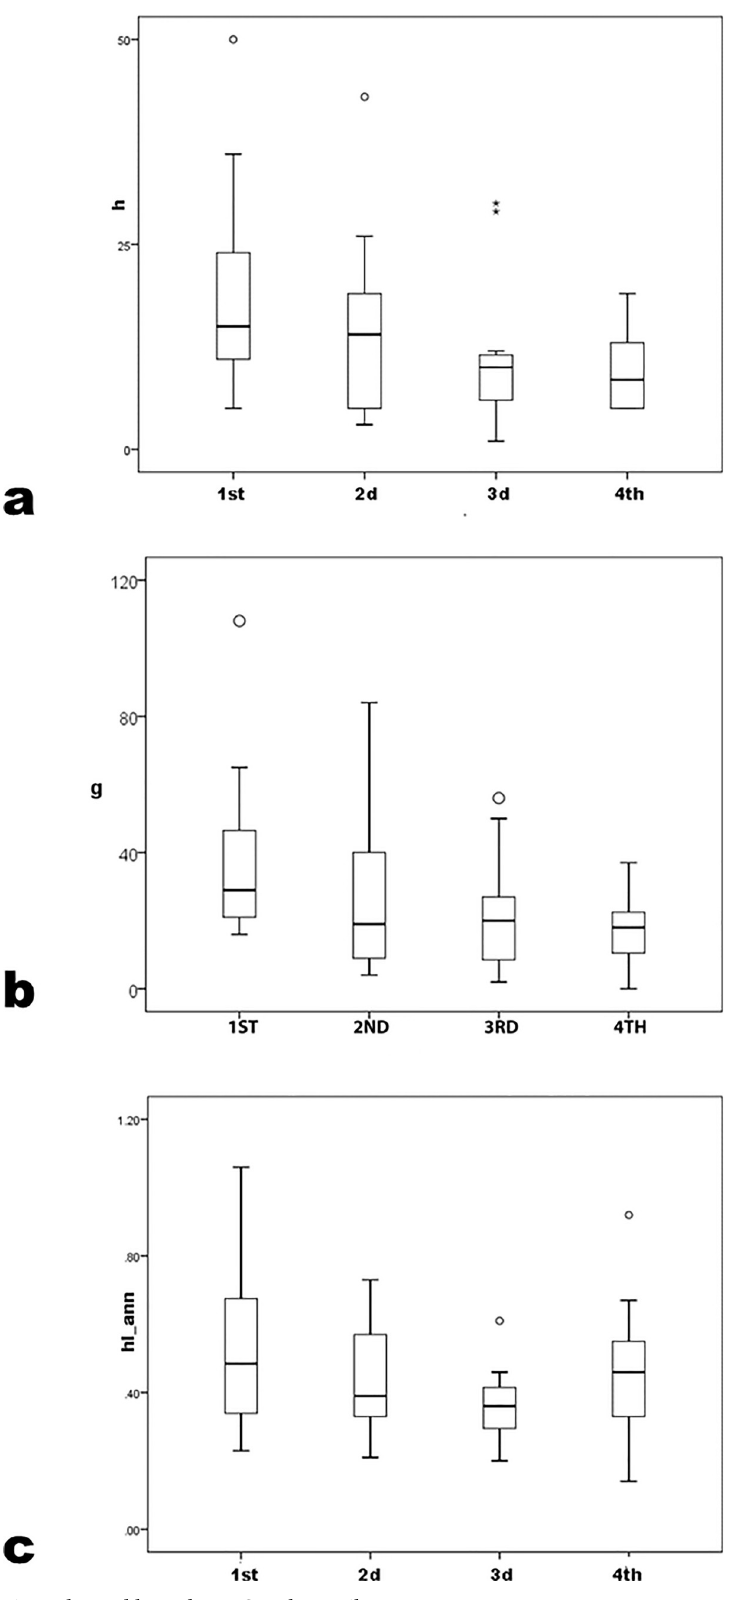
Fig 11. h , g and hIann by NRC-rank